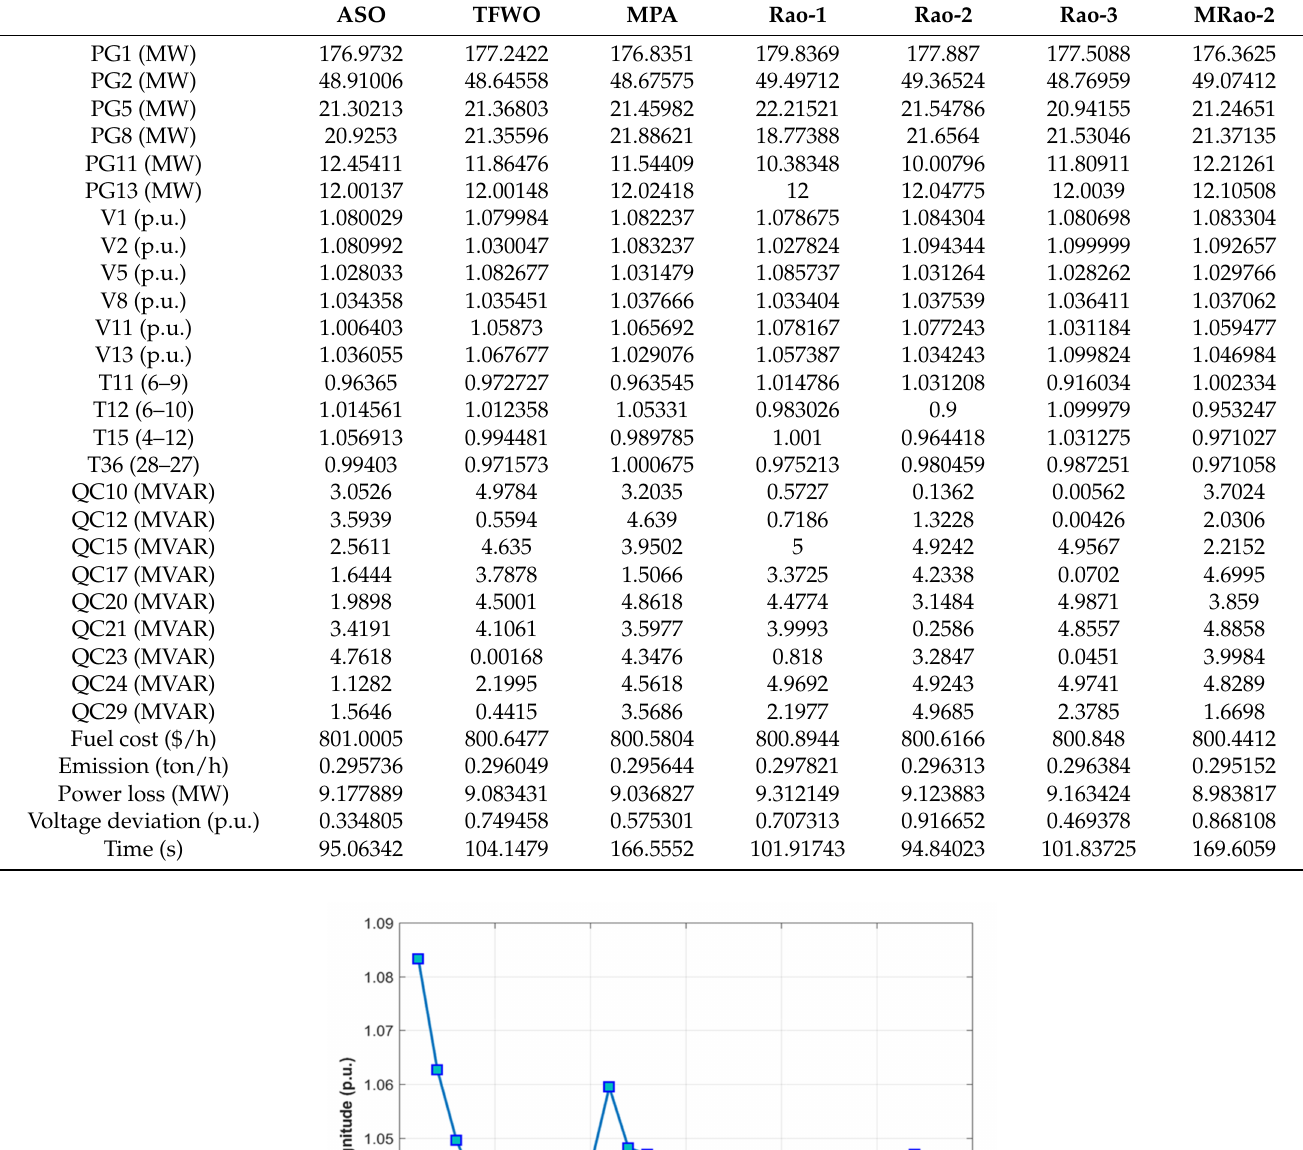
Table 4. Results of the proposed MRao-2 algorithm and other algorithms for case 1.